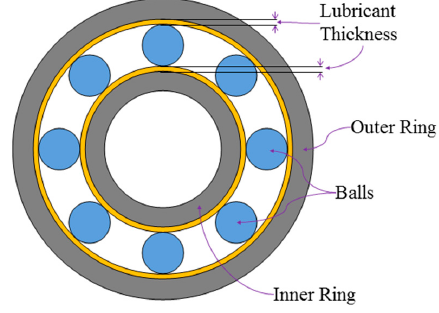
Figure 1. A deep grooved ball bearing, showing parts and the lubricant layer.